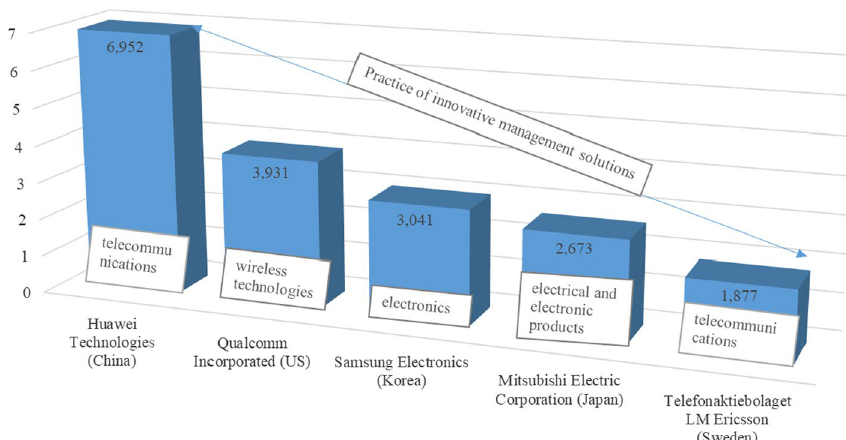
Fig. 2 Leaders of the global innovation process in the industrial sector, 2021. Source: WIPO